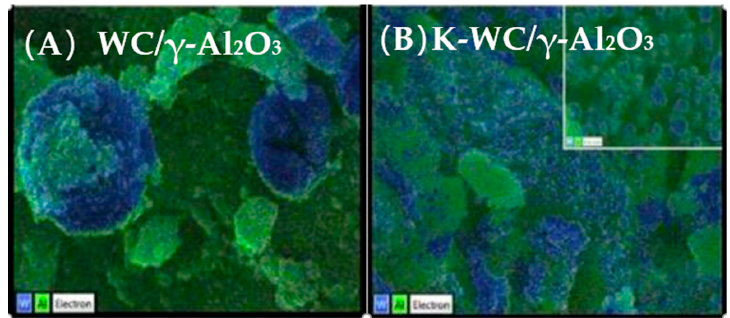
Figure 8. Scanning electron microscopy (SEM) images and corresponding energy-dispersive X-ray spectroscopy (EDS) maps for the “H 2 treated” ( A ) unpromoted, ( B ) K-promoted WC/ γ -Al 2 O 3 reprinted from [78] with permission from Elsevier.